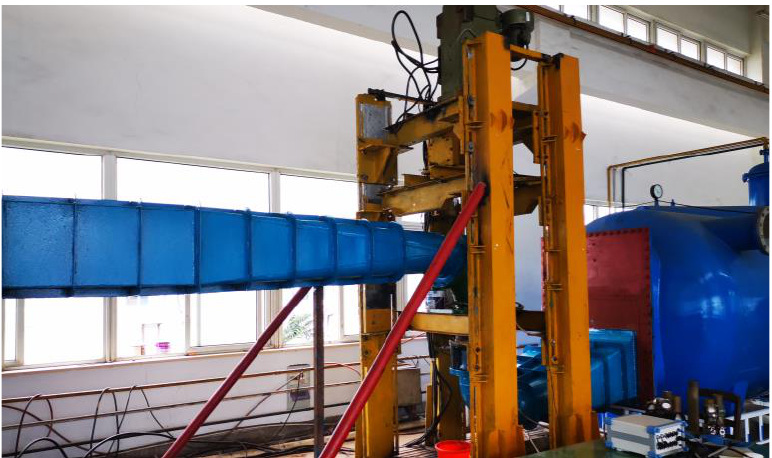
Figure 5. Experimental testing of the LAPS model.